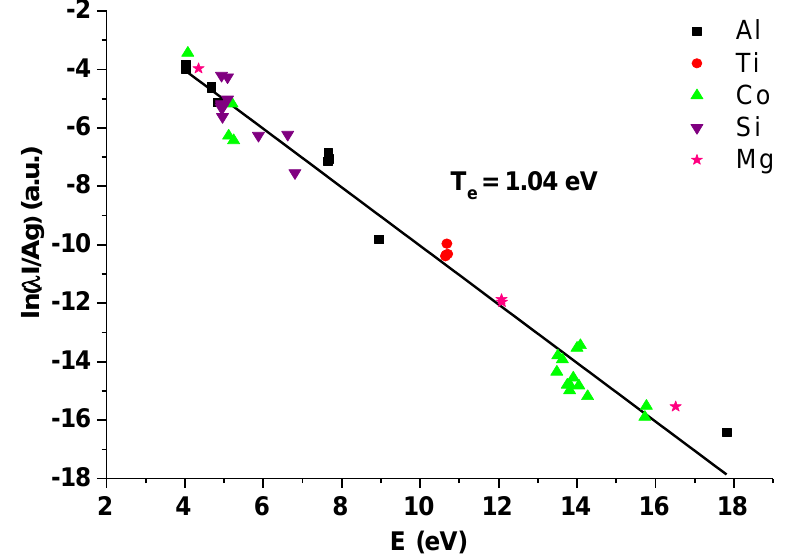
Figure 3. Multi-element Saha–Boltzmann plot for the zeolite containing 0.5 wt.% of Co (where on the vertical axis I is the line intensity, λ is the wavelength of the used spectral line, A is the Einstein coefficient, and g is degeneracy of the energy level).